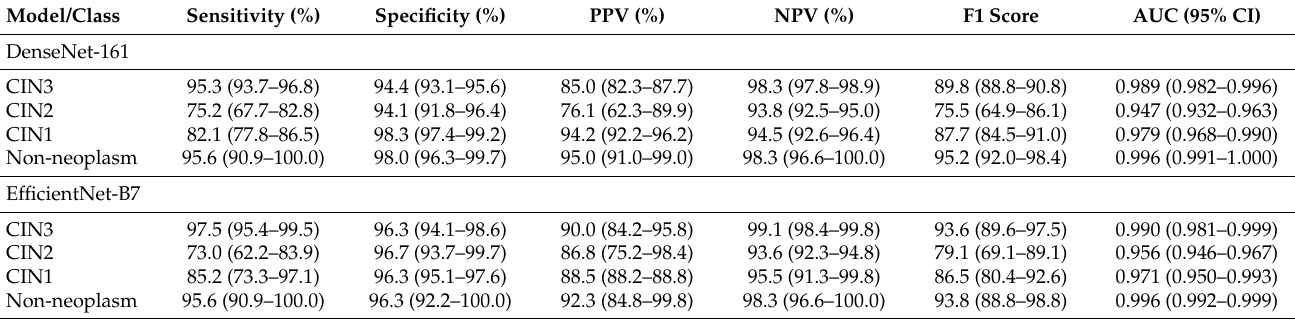
Figure 1. A training curve for training and validation accuracies. The validation accuracy reached a plateau within 20 epochs during model training.